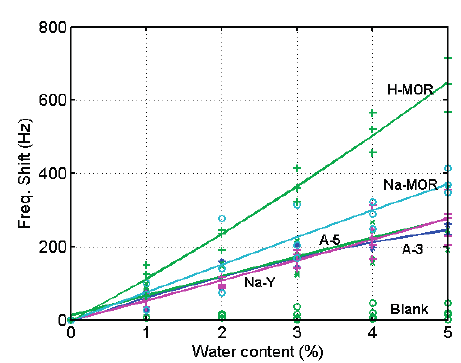
Figure 6. Comparison of frequency shifts among different zeolite